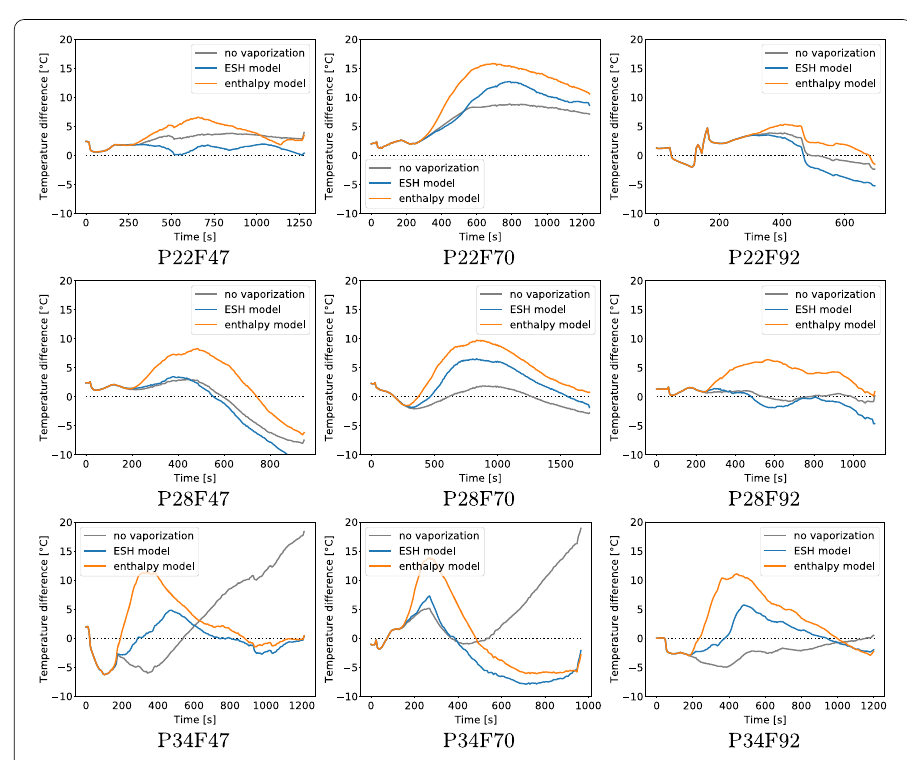
Figure 6 Difference between simulated and measured